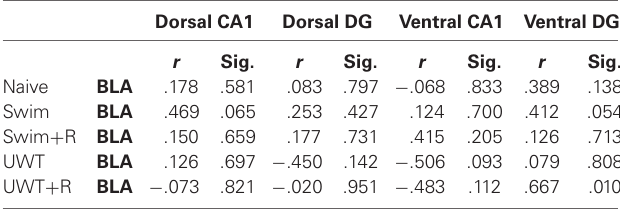
Table 1 | Pearson correlations for ERK2 activation in the BLA and